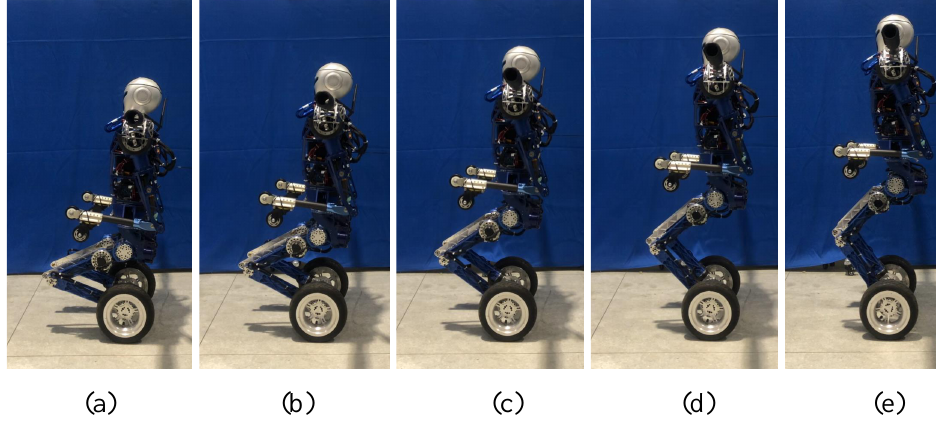
Figure 19. The experiment of the robot standing up ( a – e ).